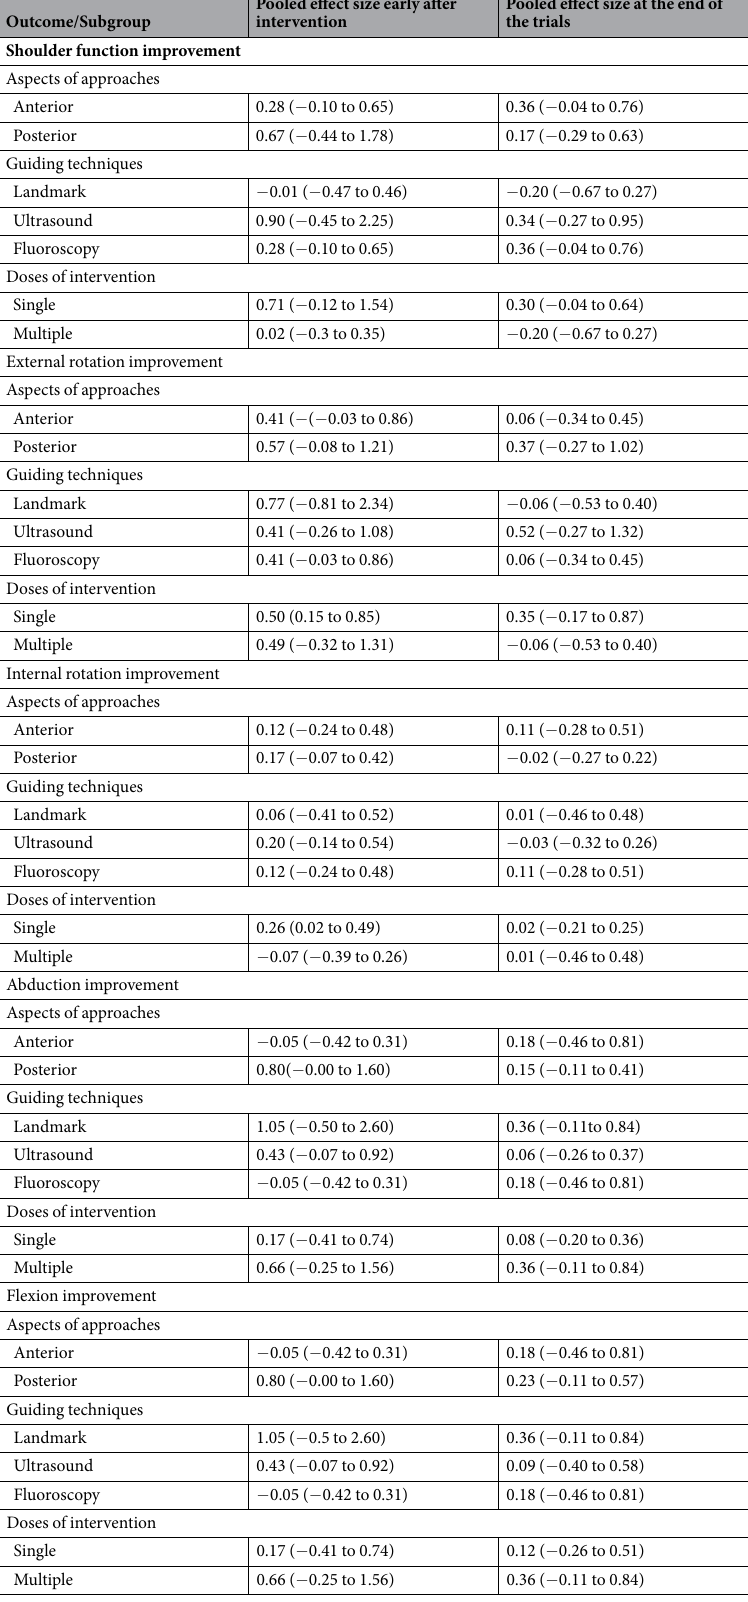
Table 2. Analysis of effect sizes comparing hydrodilatation and intra-articular corticosteroid injection stratified by the aspects of approaches, guiding techniques and doses of intervention. Note: the values are presented by their standardized mean differences with 95% confidence